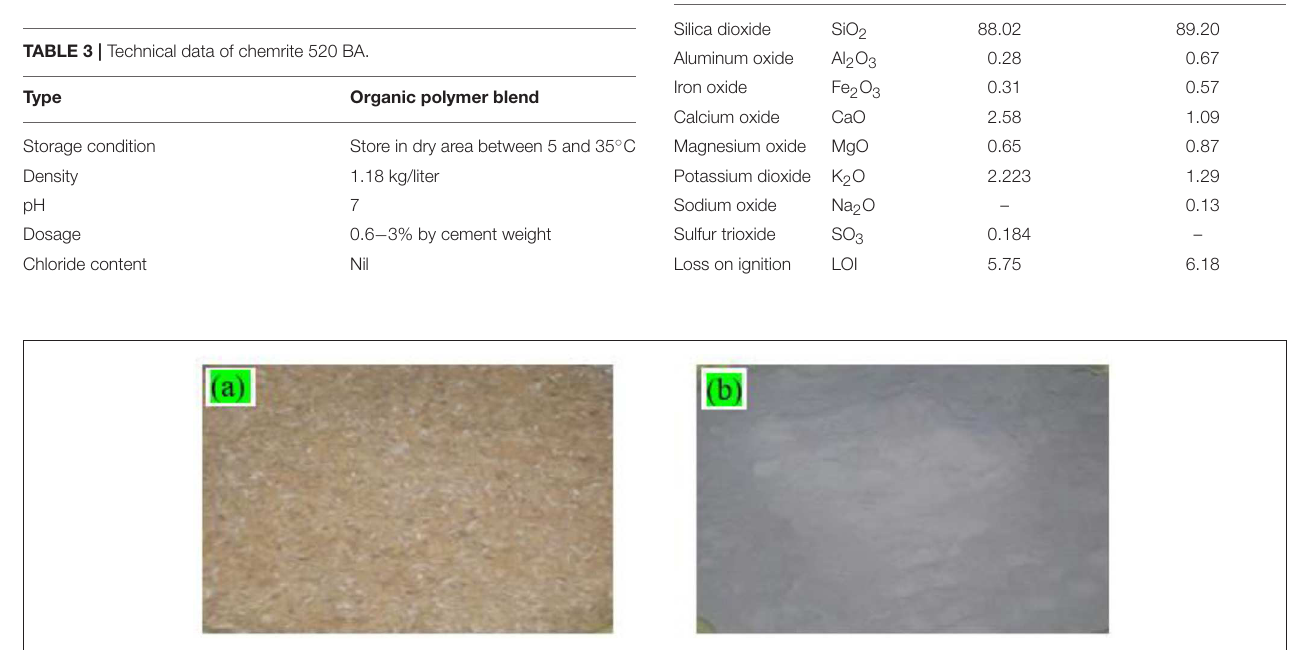
FIGURE 2 | (a) Rice husk in raw form, (b) RHA after burning at high temperatures of 700 and 950 ◦ C.